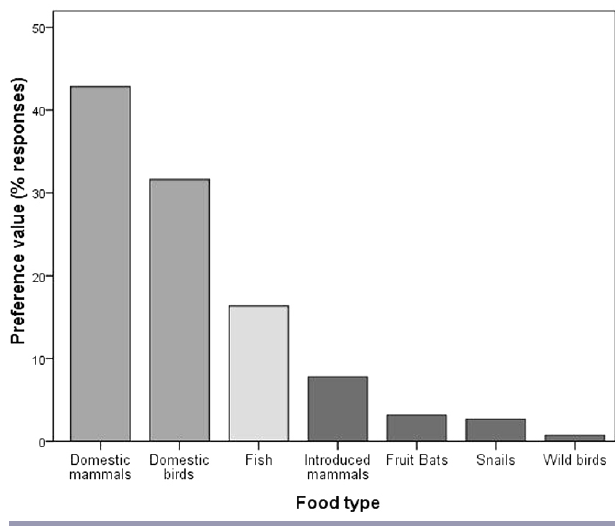
Fig. 2 . Preferred type of food named by respondents during first interview.